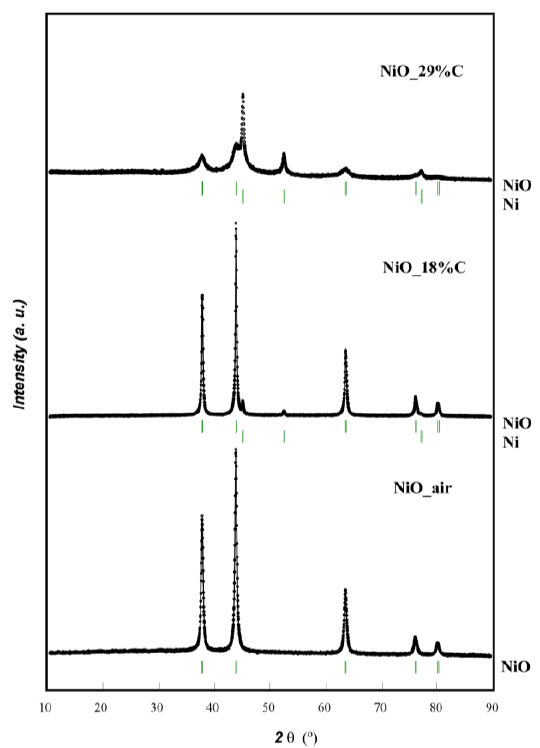
Figure 1. XRD patterns of NiO_air, NiO_18%C and NiO_29%C.